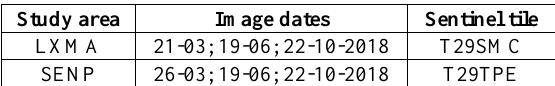
Table 1. Date and tile identifier of Sentinel-2 Images used for each study